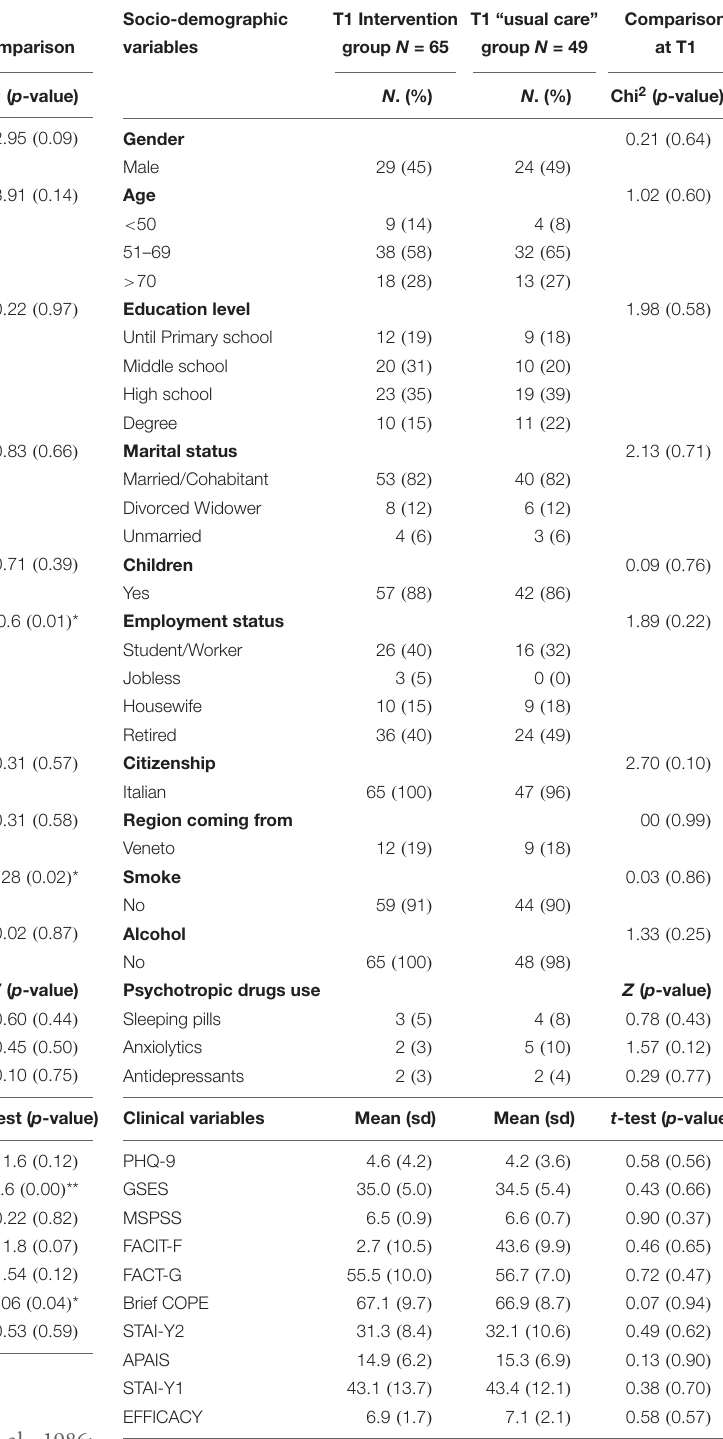
TABLE 4 | Socio-demographic and clinical variables between completers ( n = 114) and dropouts ( n = 284). Socio-demographic Completers